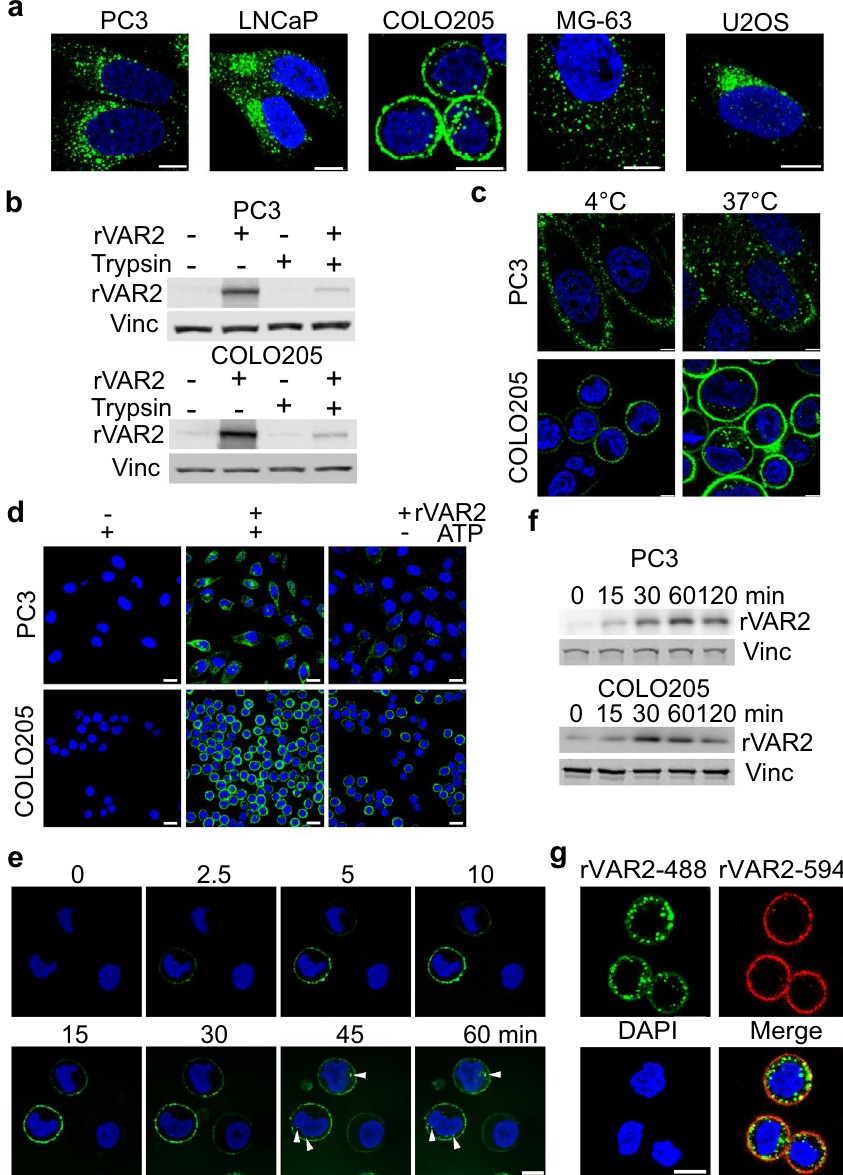
Figure 1. rVAR2 is internalized into cancer cells. ( a ) Confocal images of internalized rVAR2 in cancer cell lines after 2 h of treatment. ( b ) Western blot for rVAR2 in PC3 and COLO205 cells from lysates collected by either direct lysis on the plate or trypsinizing the cells. ( c ) Confocal images of cells treated with rVAR2 at 4 °C or 37 °C. ( d ) Analysis of rVAR2 binding with or without ATP depletion in PC3 and COLO205 cells. ( e ) Representative images from live cell confocal of rVAR2 internalization in COLO205 cells, arrow heads indicate the presence of rVAR2 inside cells. ( f ) Western blot of rVAR2 accumulation in PC3 and COLO205 cells over time. Vinculin was used as loading control. ( g ) COLO205 cells were pulse treated with rVAR2-488 and allowed to be internalized for 2 h prior to rVAR2-594. Scale bar represents 5